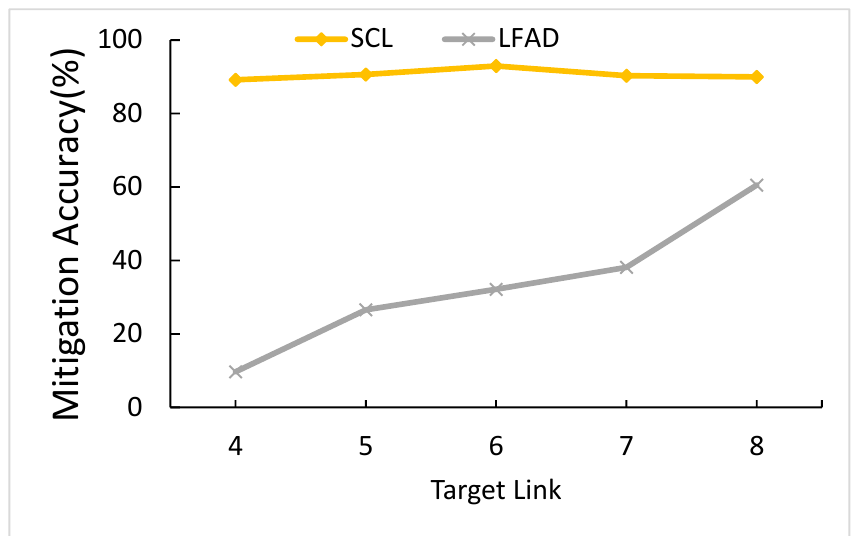
Figure 16. Comparison of the number of input